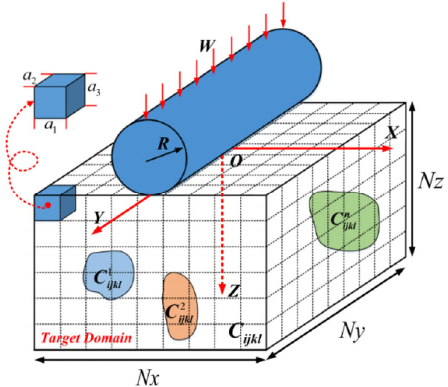
Fig. 65 A line-contact model of inhomogeneous material subjected to line-contact loading [894]. Reproduced with permission from Ref. [894], © Springer-Verlag GmbH Germany, part of Springer Nature,